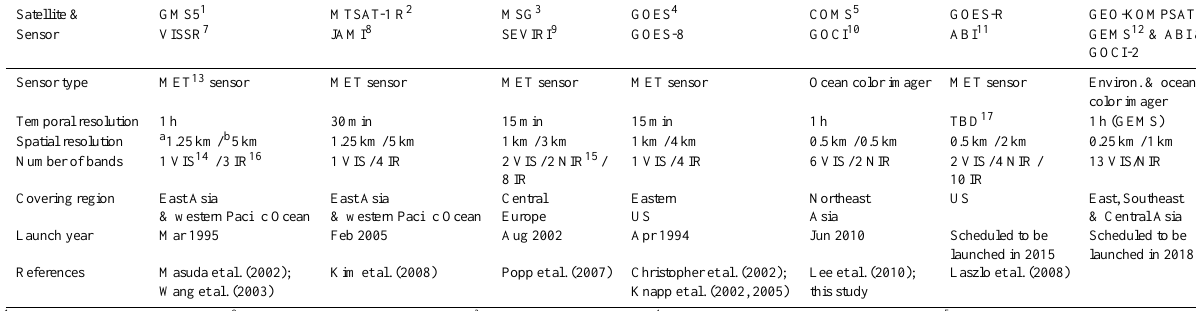
Table 1. Brief descriptions of aerosol optical property retrievals from some geostationary satellites. Satellite &